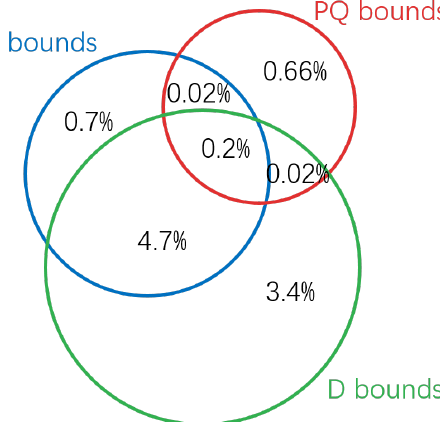
Figure 4 . Comparison of the Y bounds, PQ bounds and D bounds. The total parameter space is a 6-dimensional sphere. The percentages denoted in the corresponding areas are the percentages of the total solid angle. The blue disk schematically represents the solid angle of the parameter space that satisfies the Y bounds. The red disk represents the solid angle that satisfies the 3 types of PQ bounds, excluding the bounds that are already in the Y bounds. The green circle represents the solid angle that satisfies the D bounds (plus a 0 , because of the square roots in the D n, 0 >